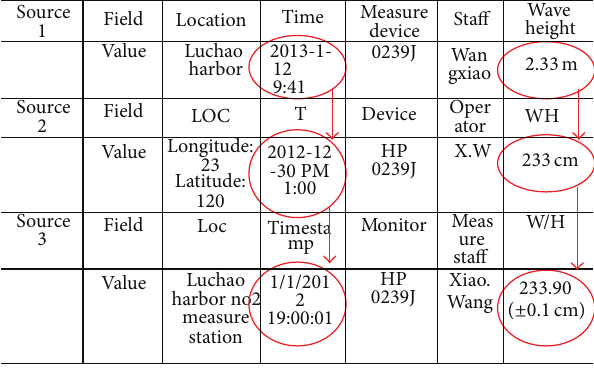
Figure 8: Marine heterogeneous data field format